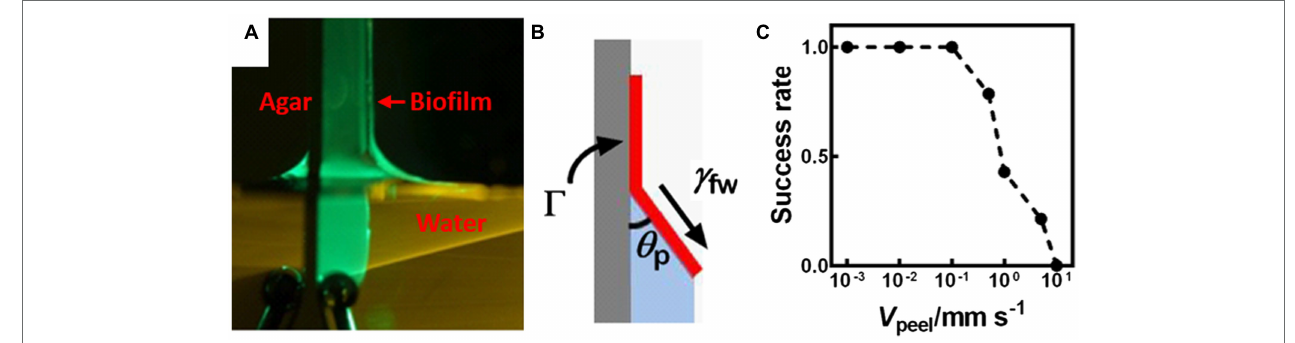
FIGURE 3 | Measurement of the adhesion energy between a biofilm and a substrate using capillary peeling. (A) Representative image of the capillary peeling process. A V. cholerae colony biofilm was first grown on an agar surface. The biofilm and the agar surface were gradually dipped into water, during which the biofilm is peeled off. (B) Schematic representation of the capillary peeling process. The interfacial tension ( γ fw ) between the water and the biofilm causes peeling of the biofilm from the substrate with a constant peeling angle ( θ p ). Γ denotes the adhesion energy (energy/area) between the biofilm and the substrate. (C) The success rate of capillary peeling decreases with peeling velocity ( V peel ), suggesting that capillary peeling relies on equilibrium conditions rather than kinetics. This figure is reproduced with permission from Yan et al.